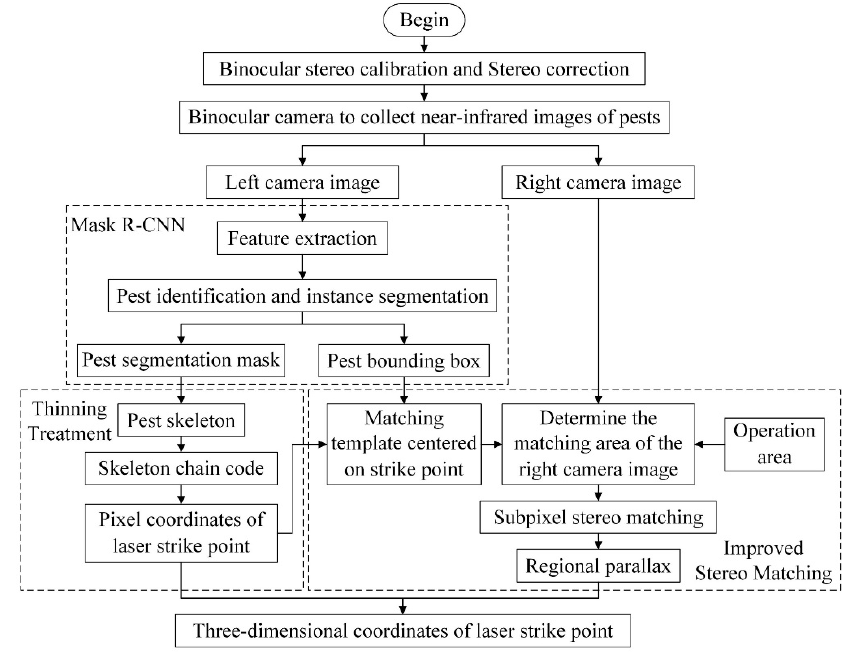
Figure 3. Structure diagram of the 3D locating system for field pests.